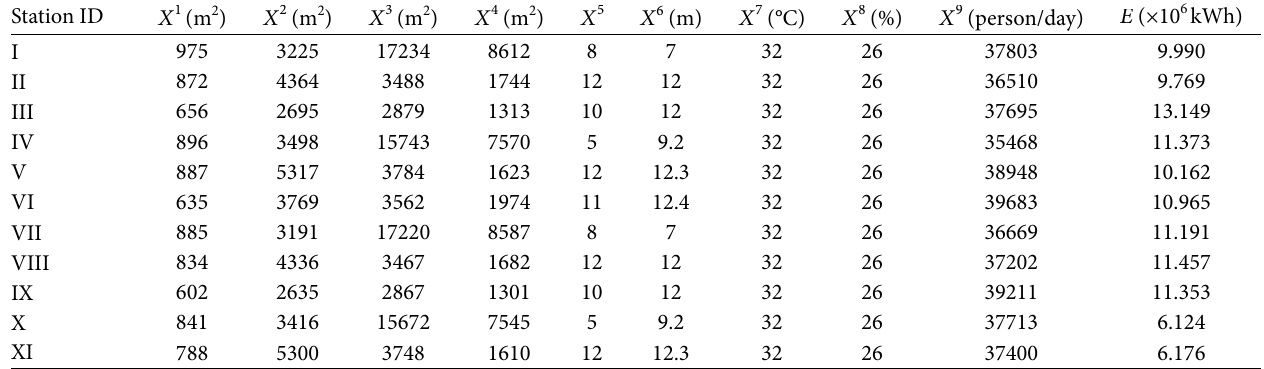
Table 3: Partial data in training dataset.